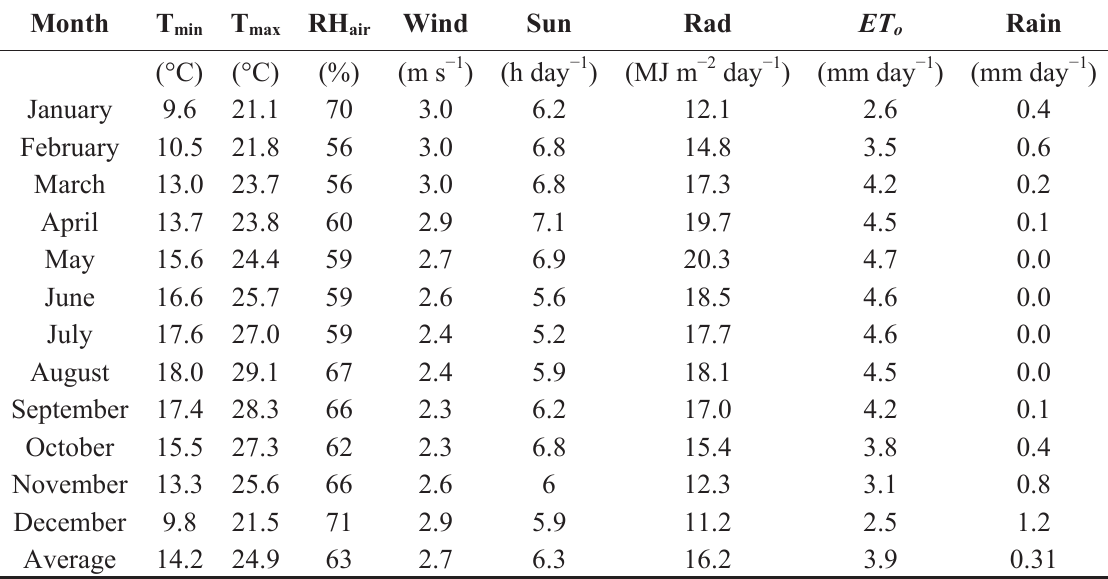
Table 1. Monthly means of minimum temperature (T humidity (RH ), wind speed (Wind), sunshine duration (Sun) and rainfall (Rain). Solar air radiation (Rad) and reference evapotranspiration ( ET Tan-Tan,